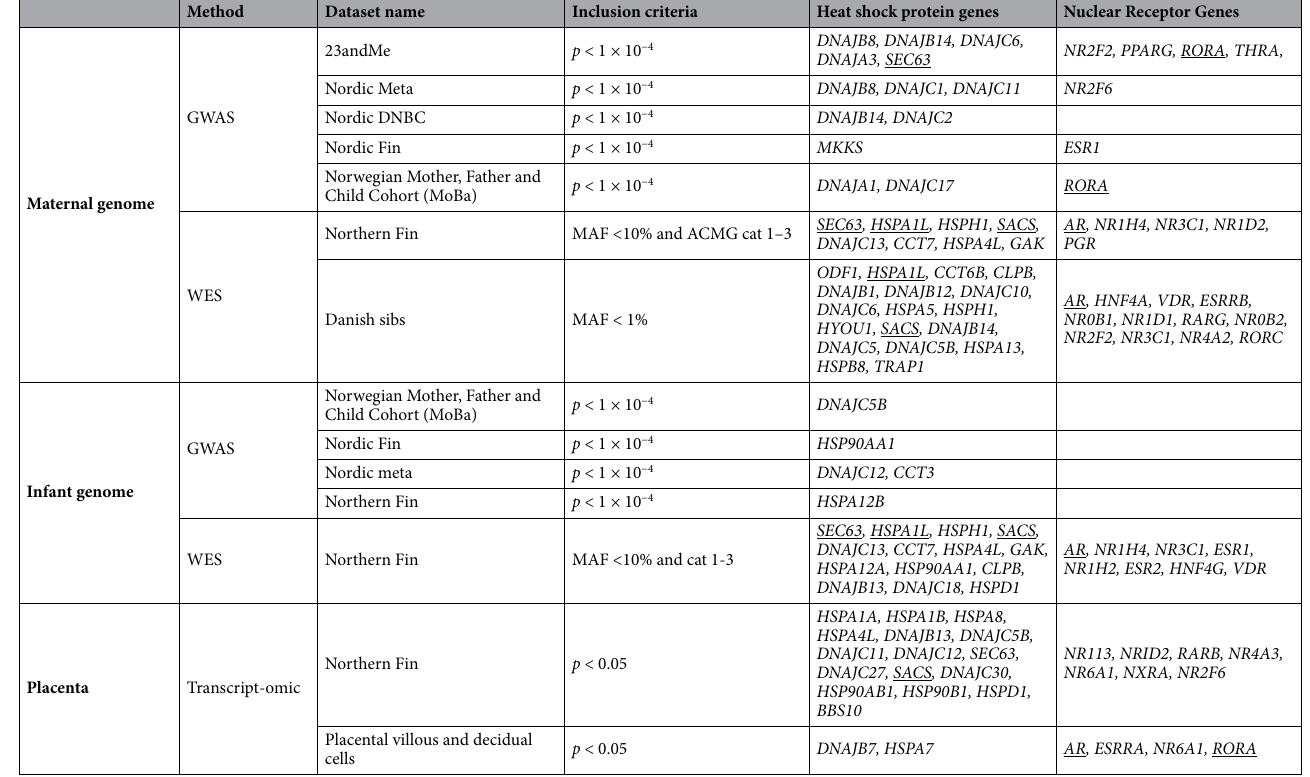
Table 1. Combined results of GWAS, WES and transcriptome datasets. Genes implicated in orthogonal datasets are